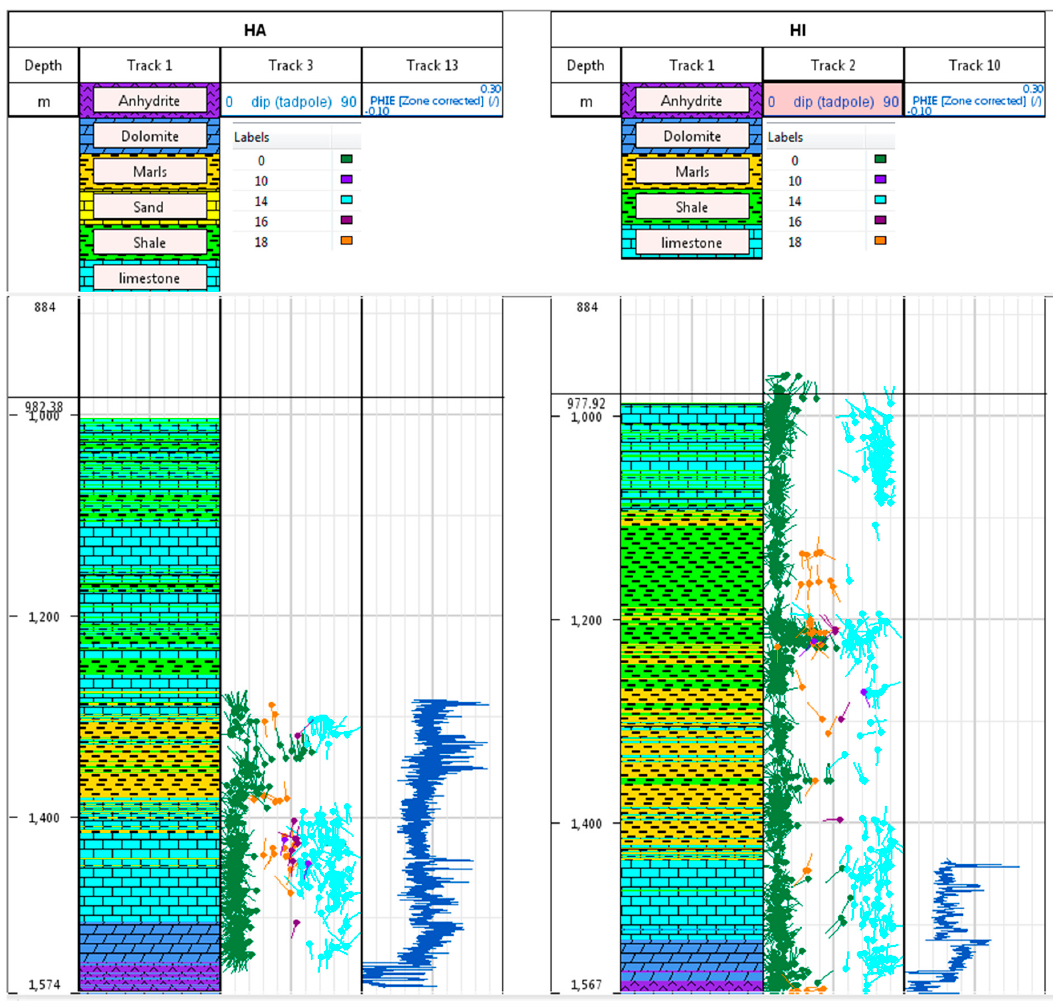
Figure 3. Facies, fracture dip–Televiewer log (Courtesy of Instituto de Ciencias de la Tierra Jaume Almera) and porosity logs for HI and HA wells.